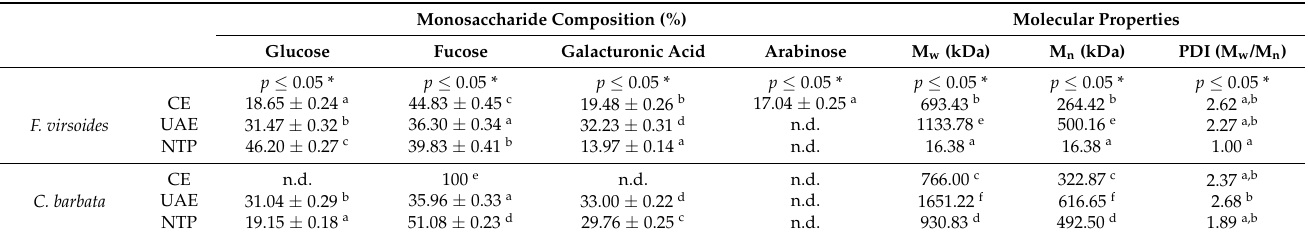
Table 5. Monosaccharide composition and molecular properties of Fucus virsoides and Cystoseira barbata polysaccharides obtained with CE, UAE and